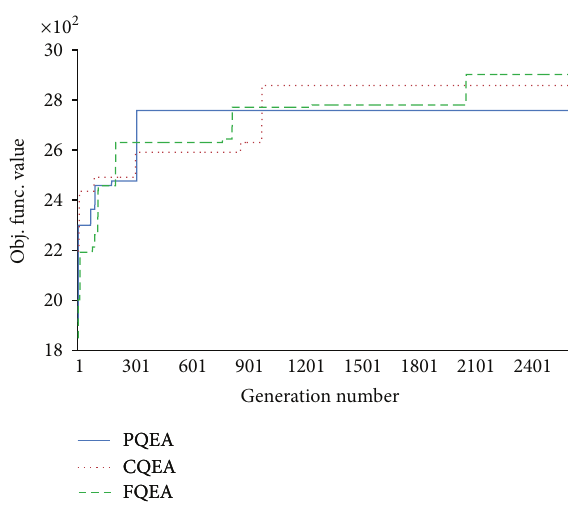
Figure 25: Convergence graph of PQEA, CQEA, and FQEA on 0-1 knapsack problem with multiple strongly correlated data instances with number of items, 𝑀 , being 200 and capacity, 𝐶 , being 1% of total weight.